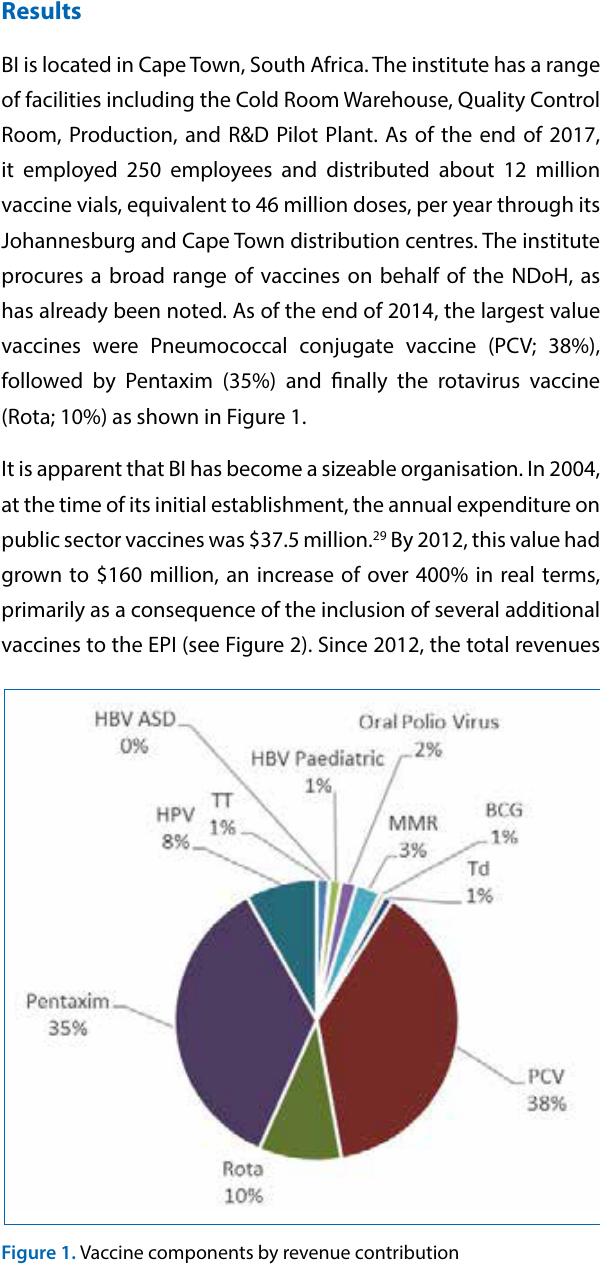
Figure 2. Growth of the Biovac Institute (2004 to 2018)